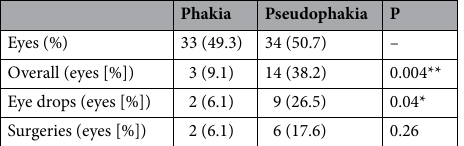
Table 4. Requirement of additional treatments in the eyes that underwent Trabectome surgery alone in phakic and pseudophakic eyes. Eyes which required both eye drops and surgeries were included in both categories. Fisher’s exact test. *P <